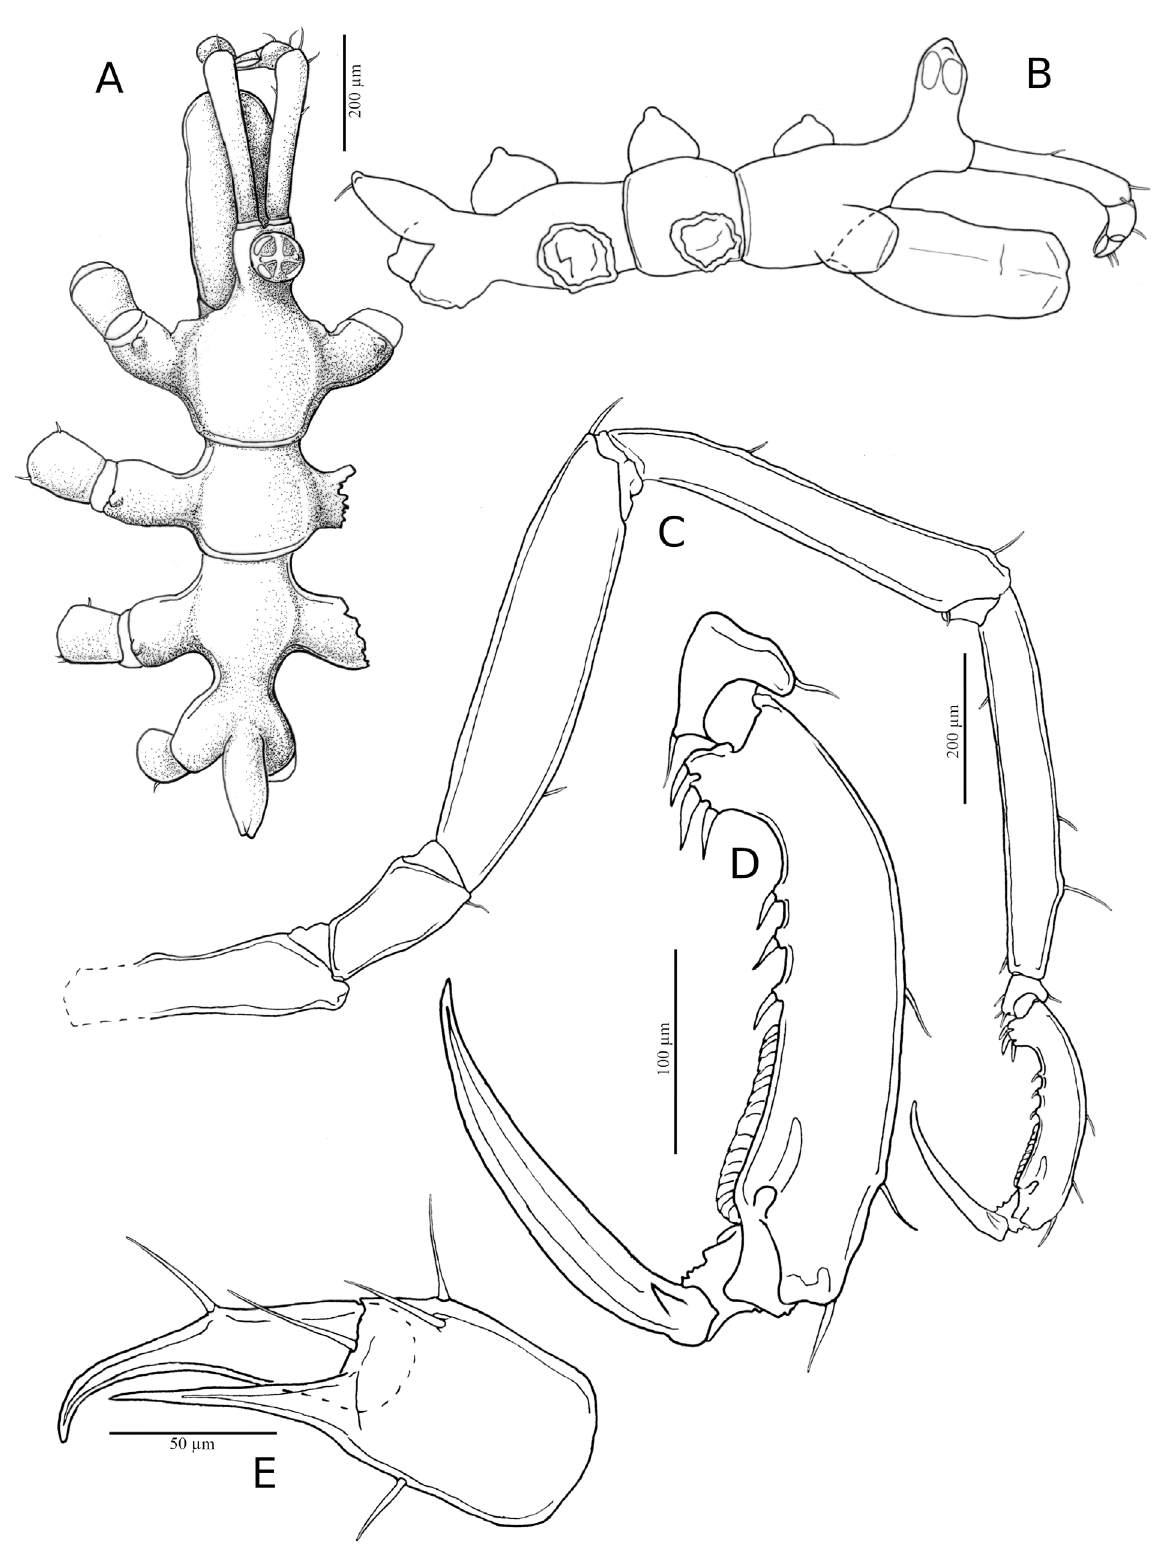
Fig. 25. Anoplodactylus sp. 4, ♀, MNHN-IU-2016-1165. A . Body, dorsal view. B . Body, lateral view (same scale as A). C . Fourth leg. D . Tarsus and propodus of fourth leg. E .